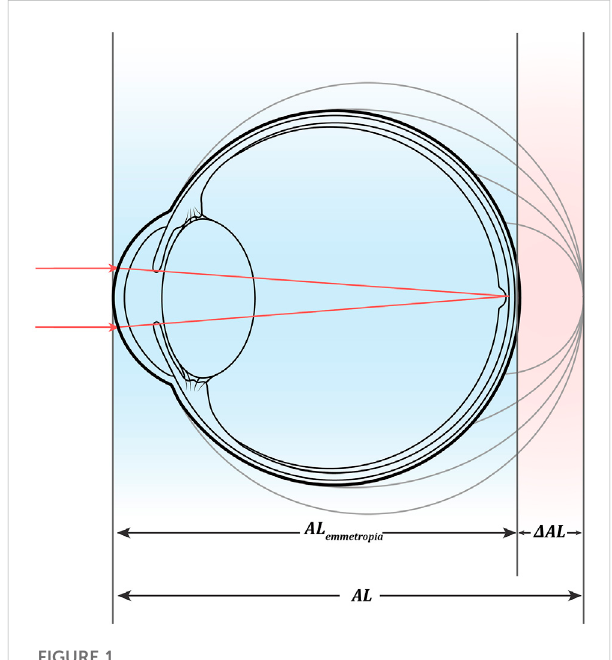
FIGURE 1 Mathematical model of axial